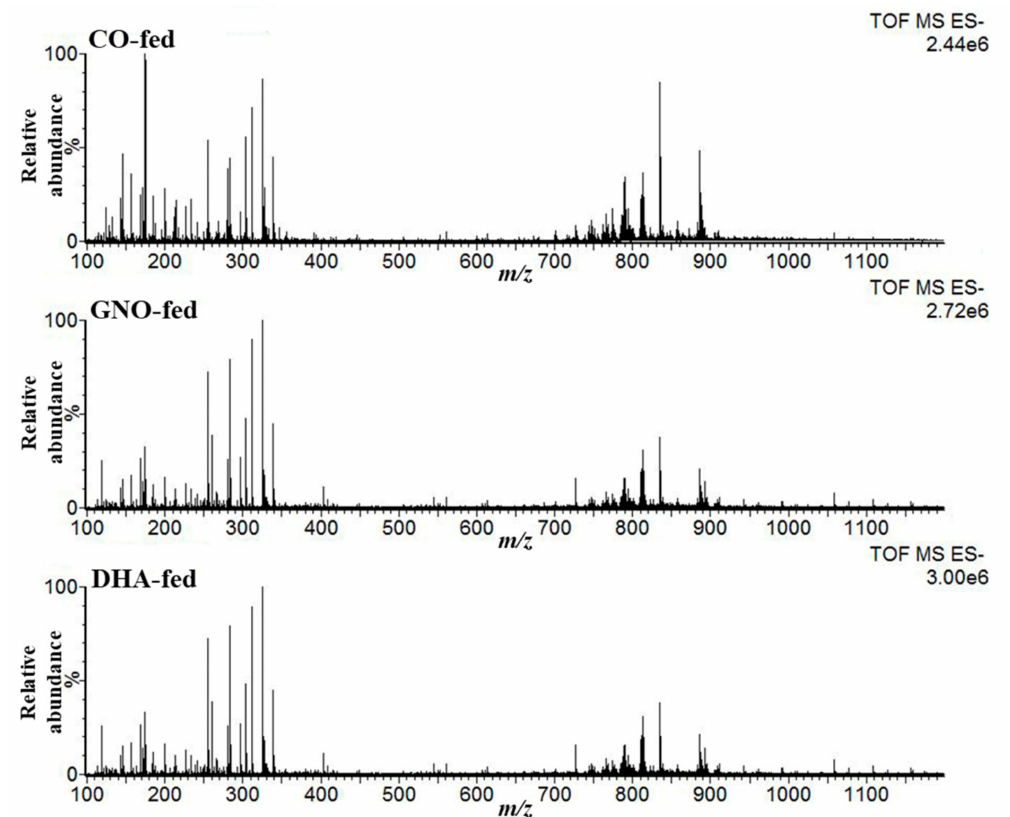
Figure 1. Representative mass spectrum of DESI-IMS at negative ion mode over m / z range 100–1200 Da acquired from sagittal slices of senescence-accelerated mouse-prone 8 (SAMP8) mouse brains. CO-fed, GNO-fed, and DHA-fed indicate corn oil-fed SAMP8 mice, green nut oil-fed SAMP8 mice, and docosahexaenoic acid-fed SAMP8 mice,